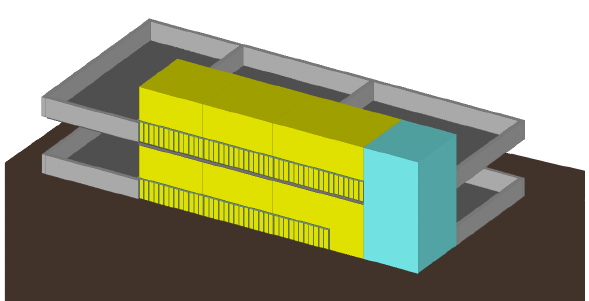
Figure 5 . Horizontal and vertical circulation space.